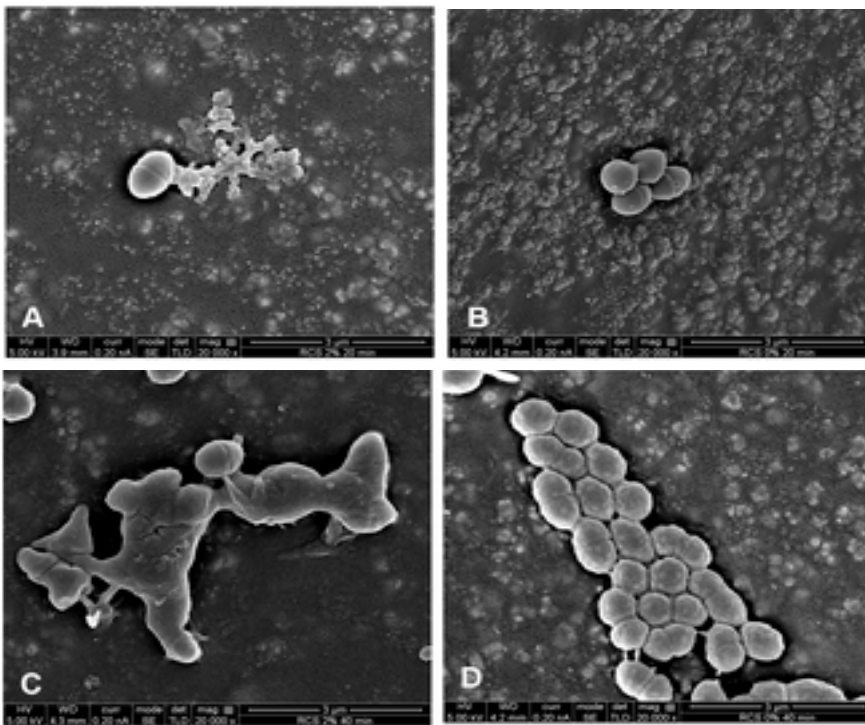
Figure 2. Images of E. faecalis following contact with the novel endodontic sealer and unmodified sealer. ( A ) E. faecalis following 20 min direct contact with the surface of the novel endodontic sealer. Syncytium like cells and bacterial lysis can be observed. Most of the bacteria show changes in morphology with no visible signs of cell division. ( B ) Bacteria following 20 min direct contact with a sealing material without QPEI nanoparticles, early biofilm formation with intact membrane and dividing cells can be observed. Bacteria on the surface of the novel sealer and the sealer without nanoparticles after 40 min, ( C ) and ( D ) respectively. Adapted from